Question: What visual encoding does this figure use to show its data?
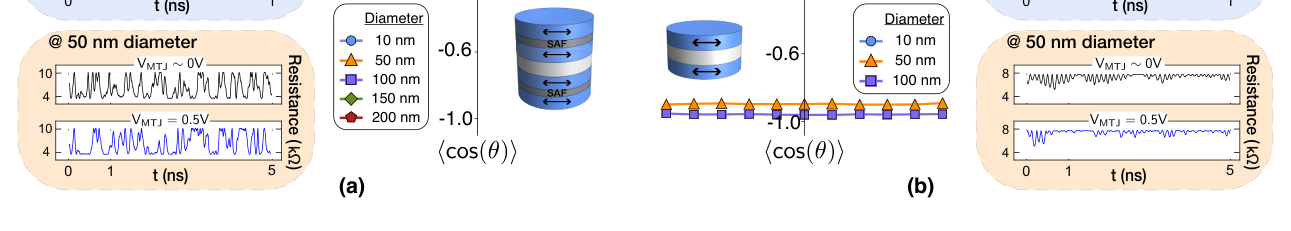
Answer: line